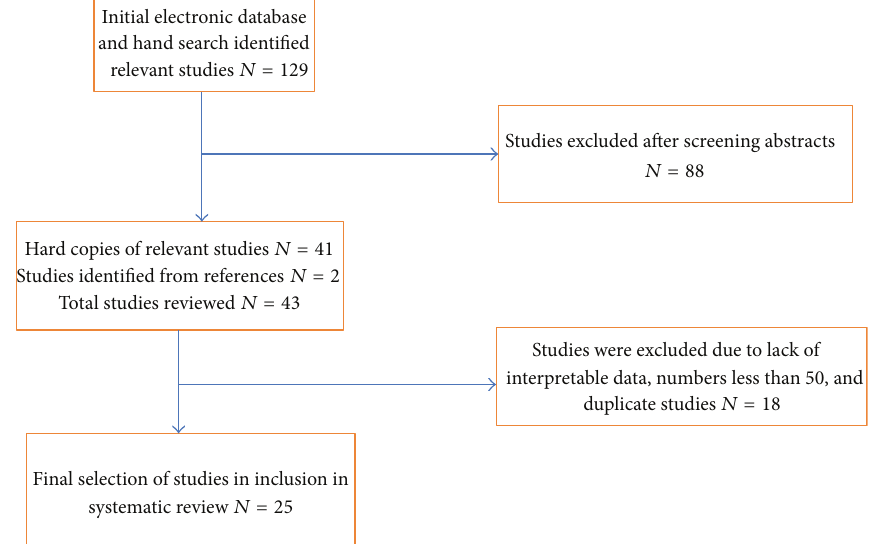
Figure 1: Study Selection for systematic